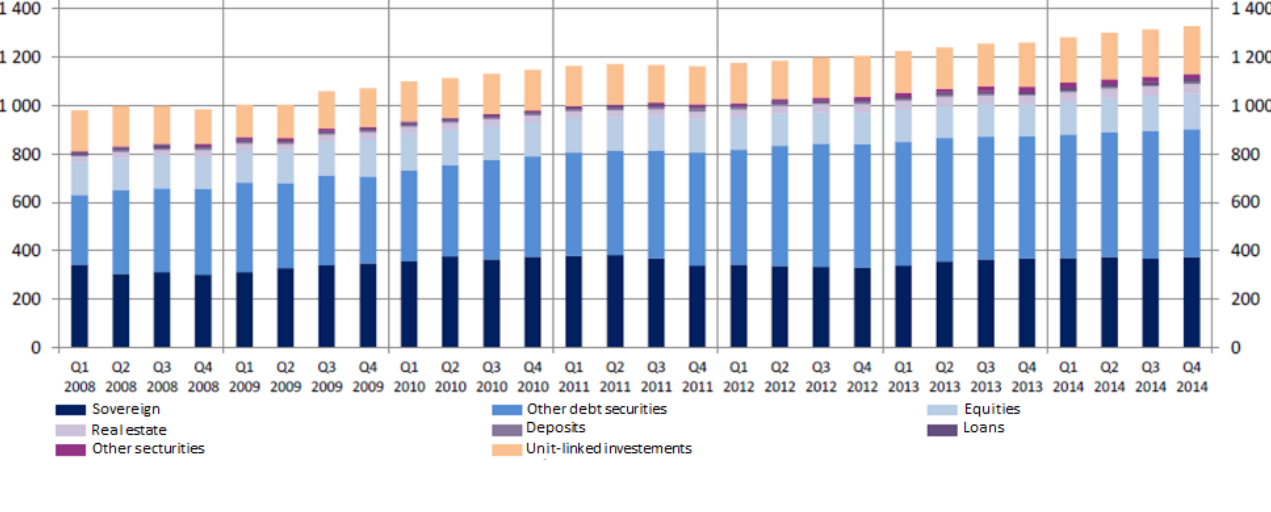
Figure A2. Credit exposures of the French banking sector ( e bn) between 2008 and 2012. Source: Chart 6 in ACPR [45].